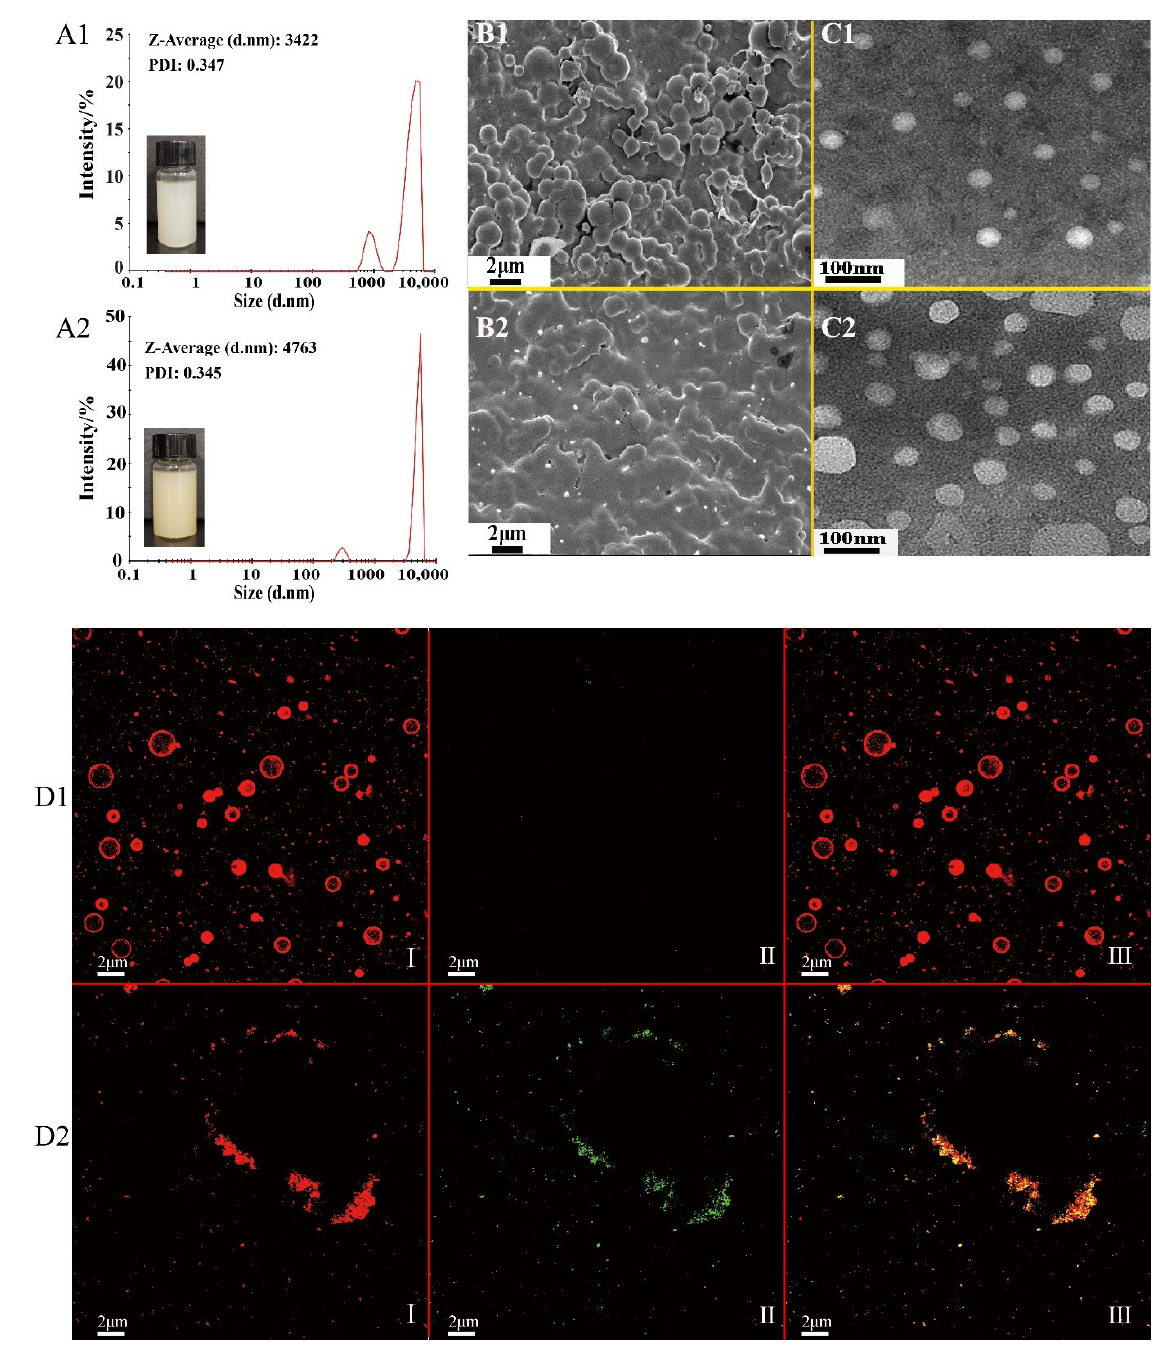
Figure 1. Changes of visual appearance and morphological property of APEs compared with PEs. A — appearance and particle size distribution of PEs ( A1 ) and APEs ( A2 ), B — SEM images of PEs ( B1 ) and APEs ( B2 ), C — TEM images of PEs ( C1 ) and APEs ( C2 ), and D — CLSM images of PEs ( D1 ) and APEs ( D2 ). In ( D1 ) and ( D2 ) , “I, II, and III” represented zein stained red with fast green FCF, Asta oil phase stained green with Nile Red, and double channel images formed by I and II, respec-tively.